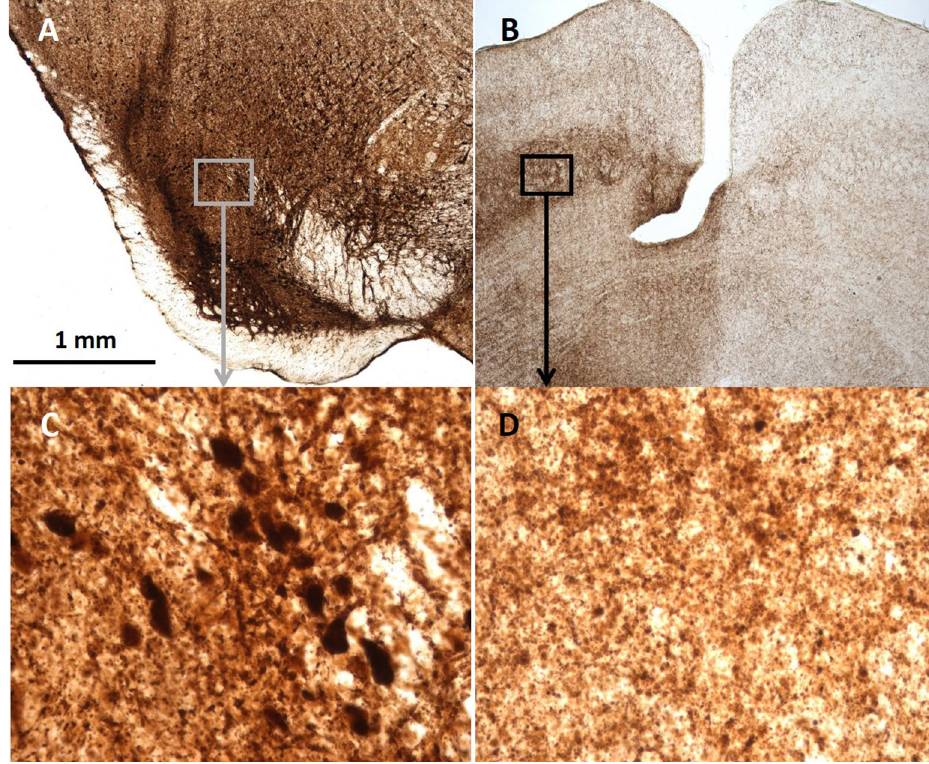
Figure 1. Detection of human α-synuclein immunoreactivity (IR) in the superior colliculus of rats injected with AAV- α-synuclein. ( A–D ) Images of immersion fixed brain slice stained with the 4B12 antibody for human wild-type α-synuclein and magnified 10 × and 40 × . ( A ) Human wt α-synuclein IR in the substantia nigra pars compacta (SNc). ( C ) A subsection of the human α-synuclein IR in the SNc at 40 × magnification. The magnification highlights cell bodies containing human wt α-synuclein. ( B – D ) Human wt α-synuclein IR appearing in the intermediate gray layer of the superior colliculus